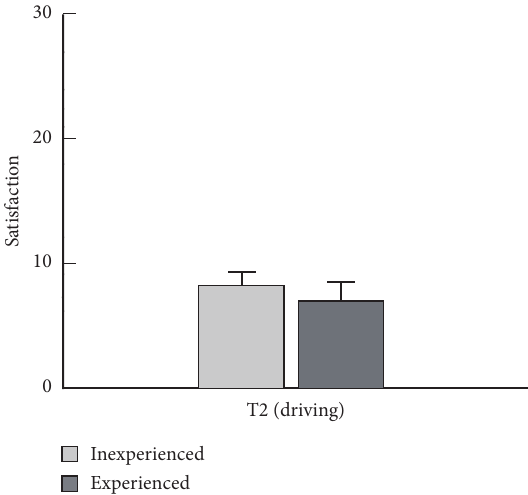
Figure 4: Satisfaction in different